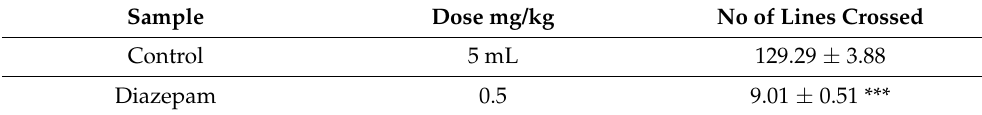
Table 3. The sedative potential of salicylalazine purified from M. biflora in the open field